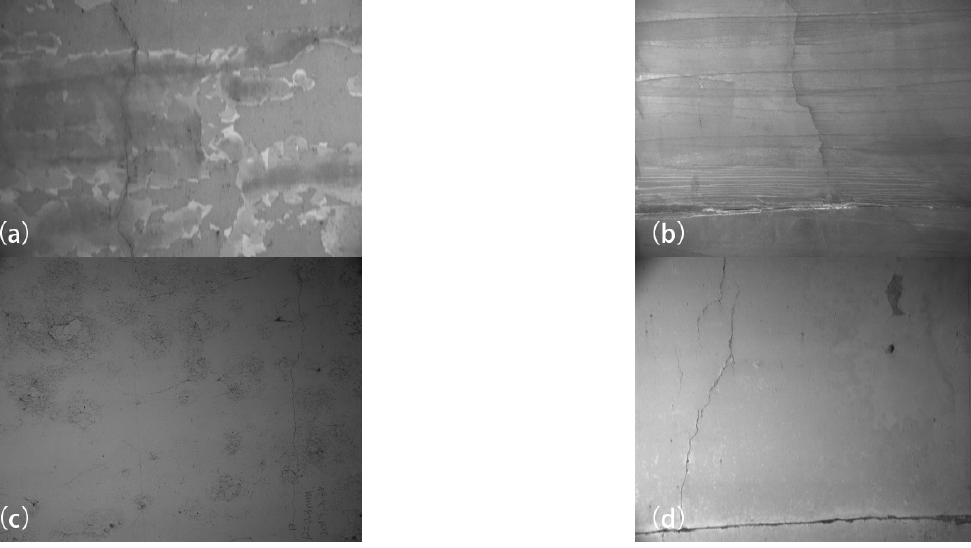
Figure 13. Images of tunnel lining cracks, ( a ) cracks picture with breakage, ( b ) cracks picture with seepage, ( c ) cracks picture with stains, ( d ) cracks picture with expansion joint.